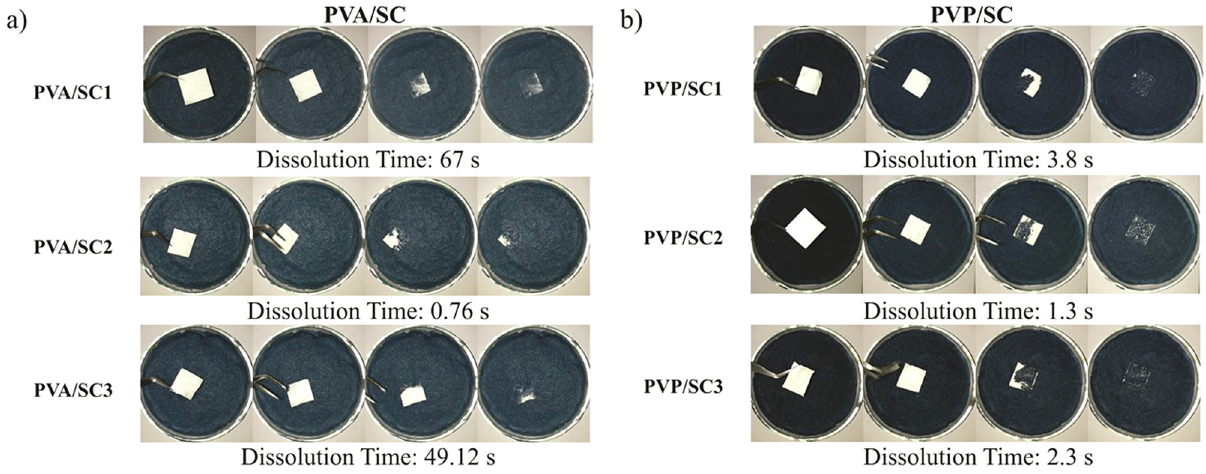
Figure 6: Wetting tests on the fi brous sca ff olds: ( a ) PVA/SC fi bers, ( b ) PVP/SC fi bers.